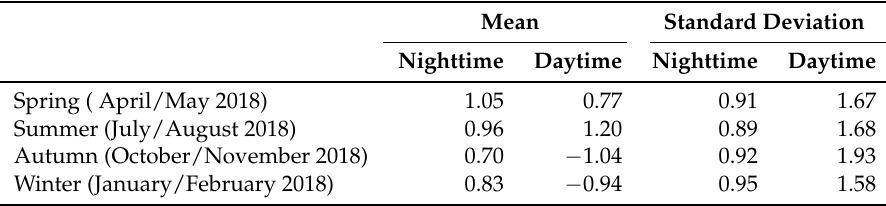
Table 4. Statistics (Mean and standard deviation) of IASI LST compared to SEVIRI LST (in K).